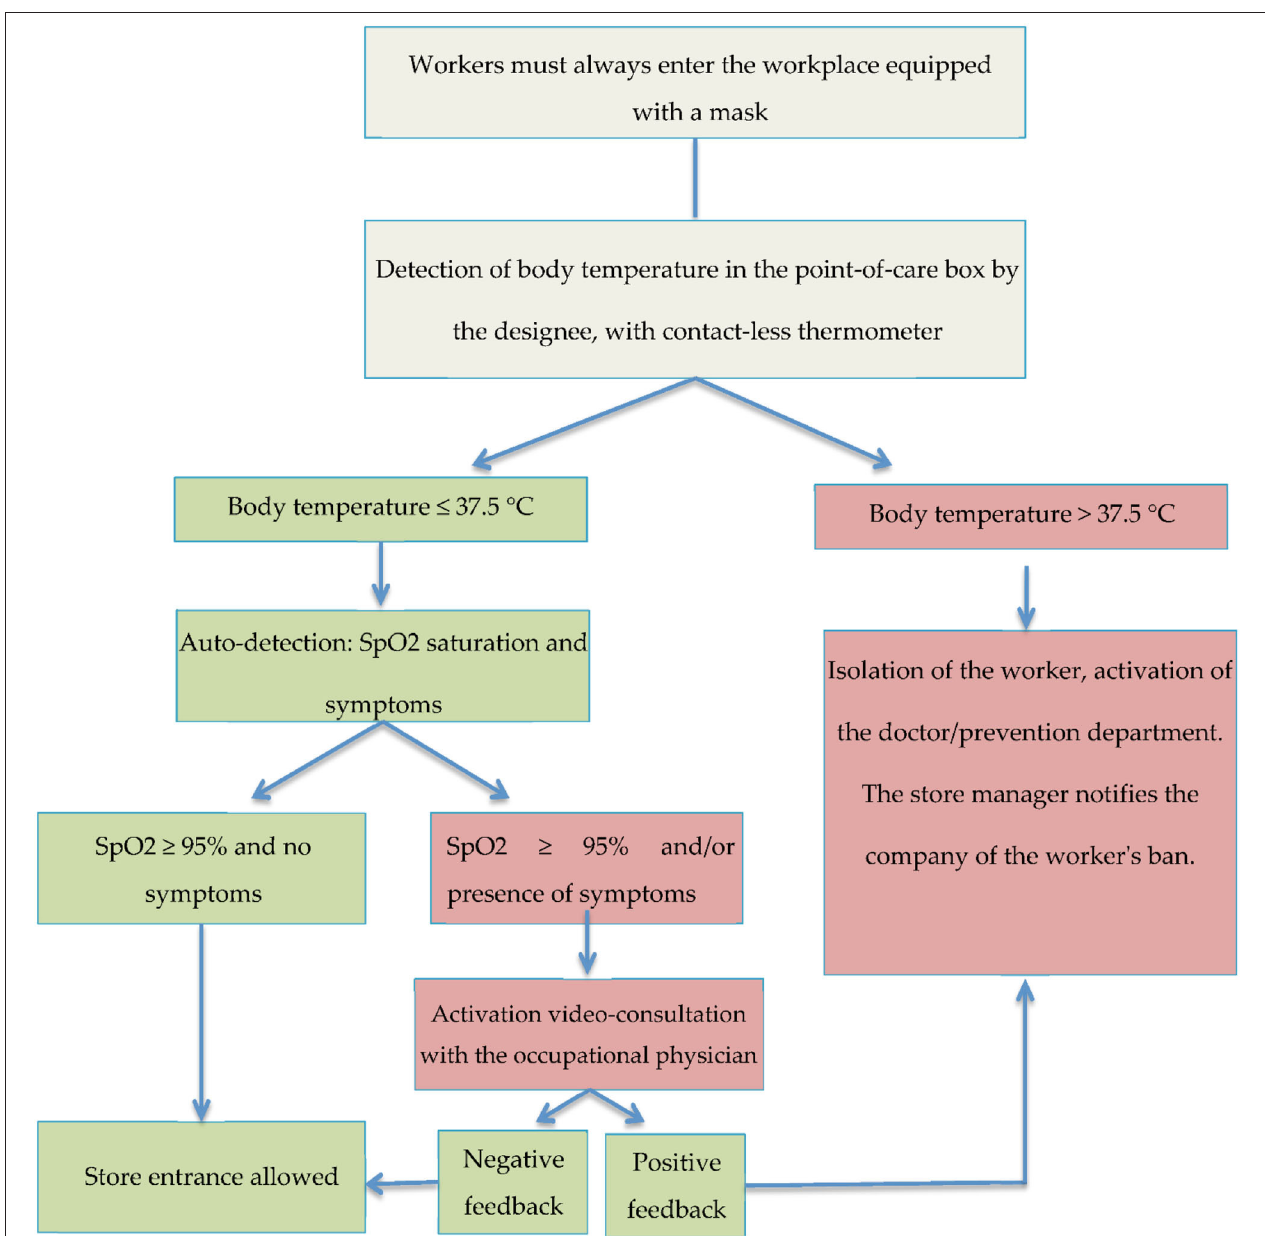
FIGURE 1 | Flow chart with anti-COVID-19 procedures to be followed when entering the company.